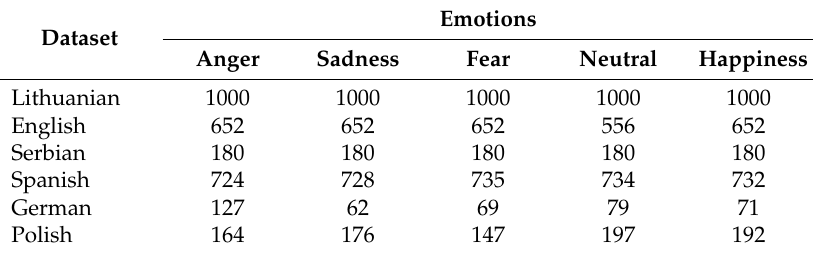
Table 2. Corpora information: sampling number for each emotion.